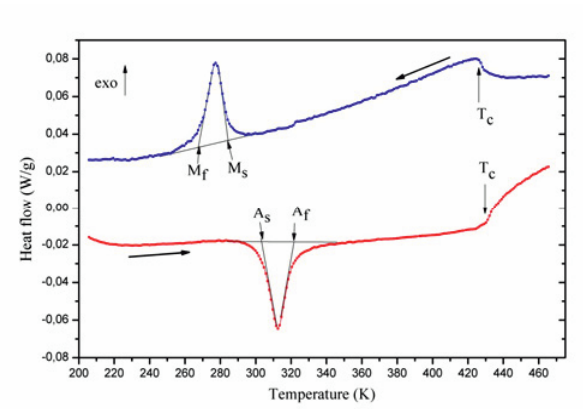
Figure 4. The calculated entropy change curves for the whole experimental magnetic field range of the ZFC protocol.